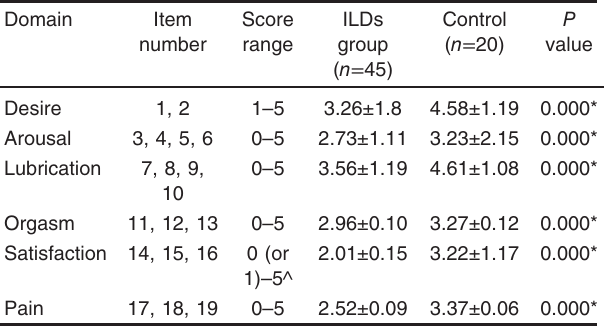
Table 4 Domain scoring of female sexual function index in both groups